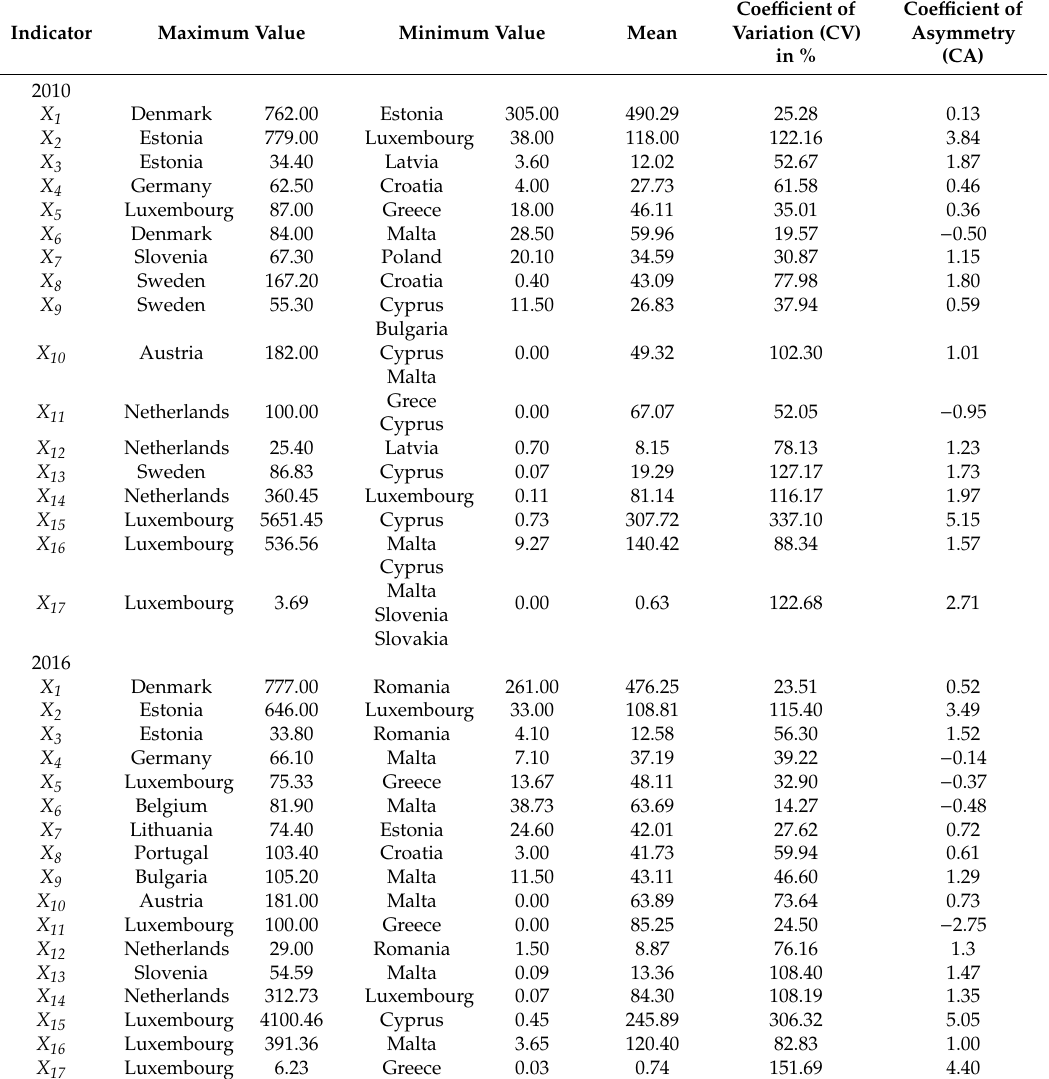
Table 1. Descriptive statistics of variables in 2010 and